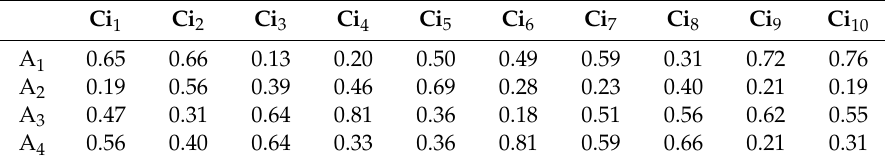
Table 19. The normalized values of the judgments matrix.